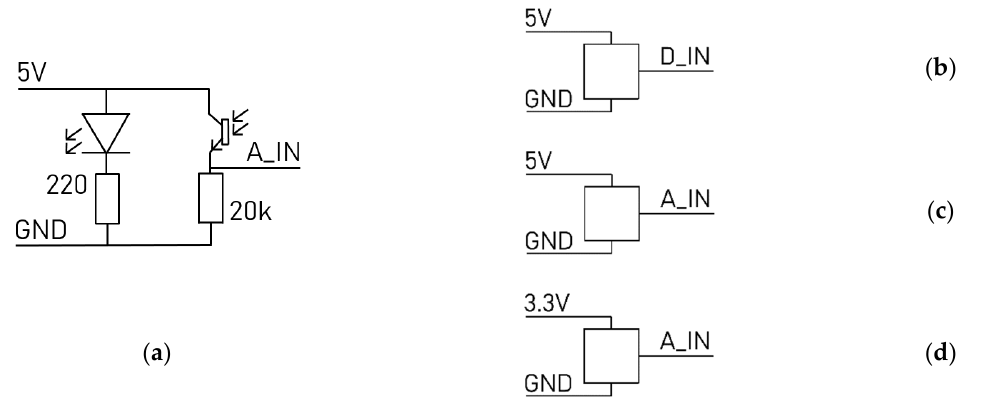
Figure 9. ECG, finger and ear heartbeat sensors’ voltages vs. time. In this third measurement, the target is standing and bending their knees multiple times between 5 and 10s.